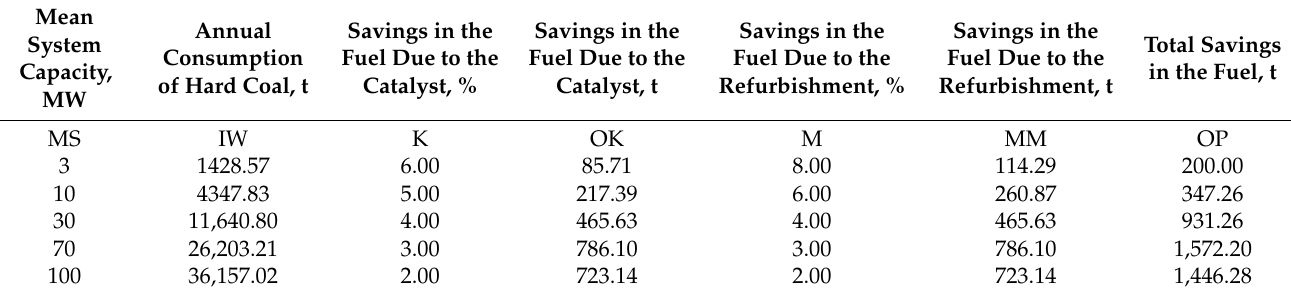
Table 3. Savings in the fuel due to the use of the system that improves fuel-combustion efficiency.